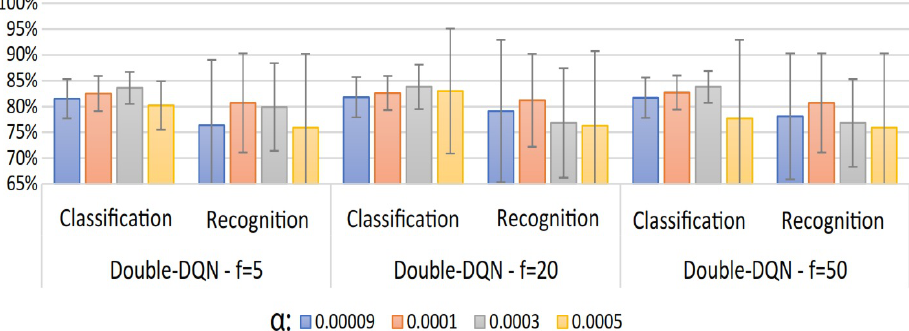
Figure 8. User-specific HGR model classification and recognition accuracy results for 20 users with different values of learning rate ( α ) and update frequencies for Double-DQN.